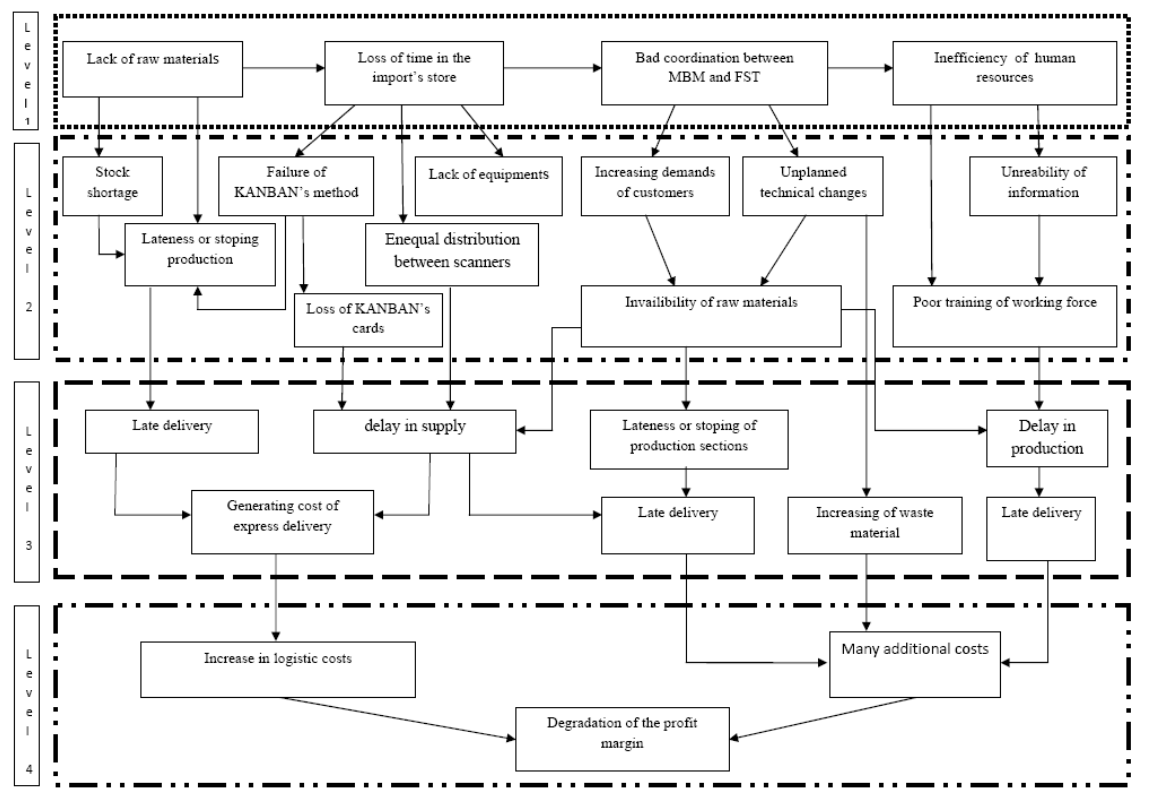
Figure 4: Results decomposed by